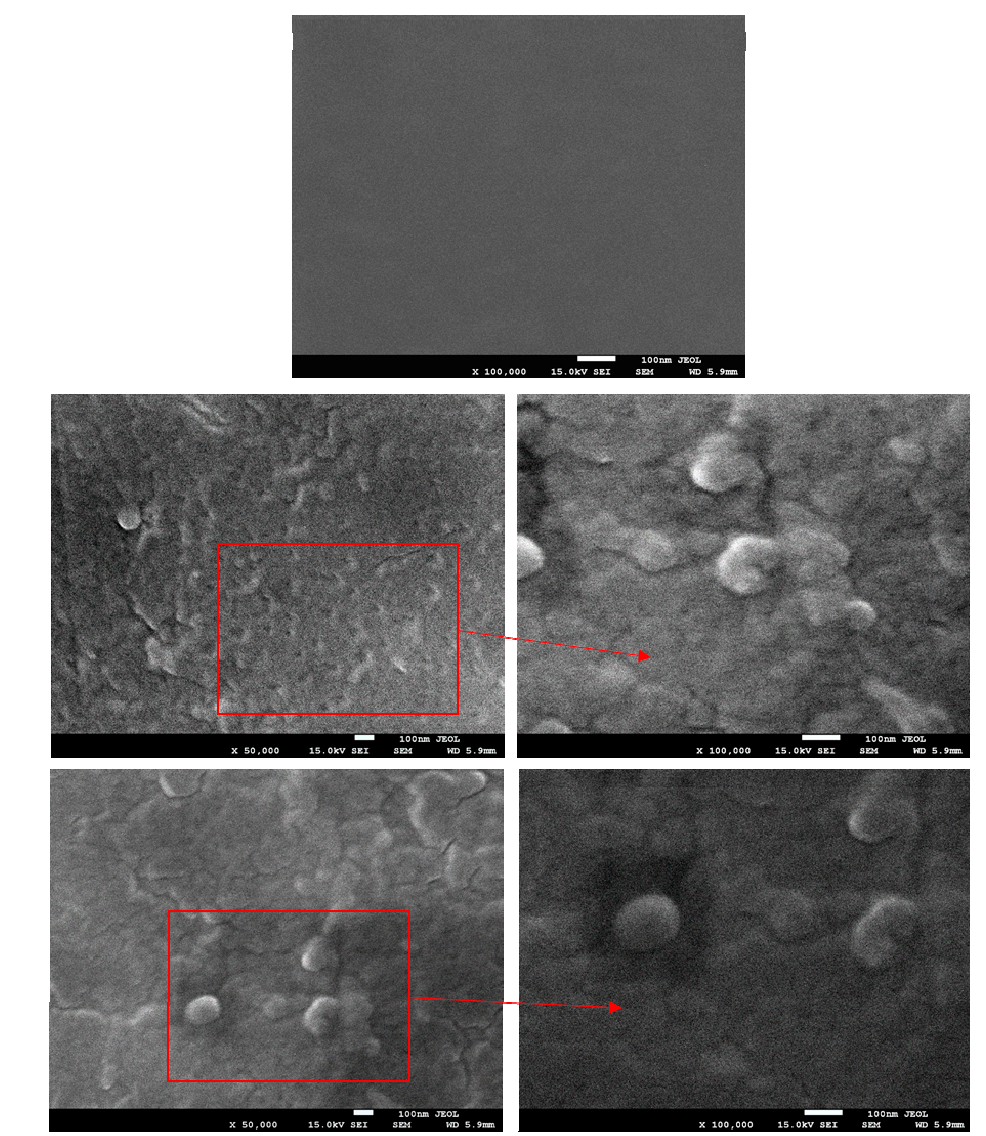
Figure 2. SEM images of ( A ) FUR-CSGH films and (B) FUR microcapsules with CSGH.